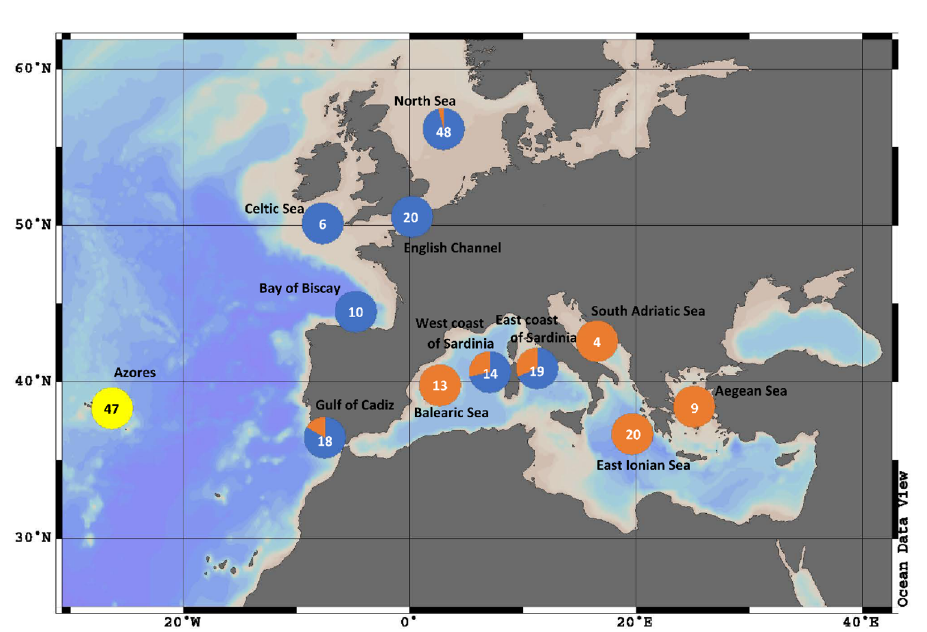
Figure 4. Geographical distribution of the Azores clade (yellow), “East Atlantic” clade (blue) and the “Mediterranean” clade (orange) of L. forbesii in Europe (sample size depicted inside circles) based on COI- sequences (Ocean Data View version